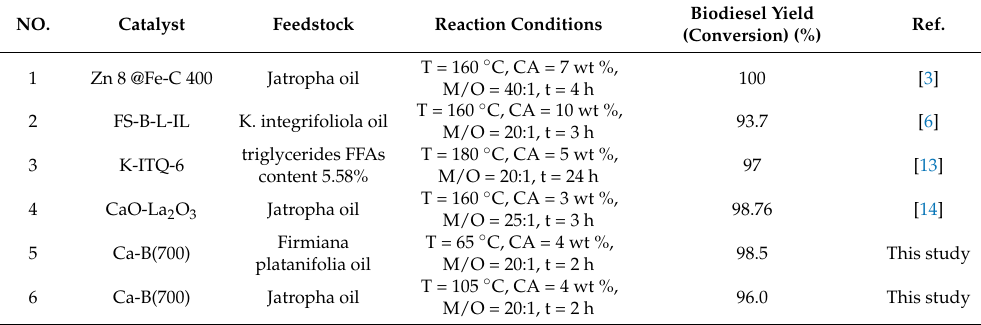
Table 3. Comparison of the performance of different heterogeneous Table 3 Comparison of the performance of different heterogeneous catalysts.